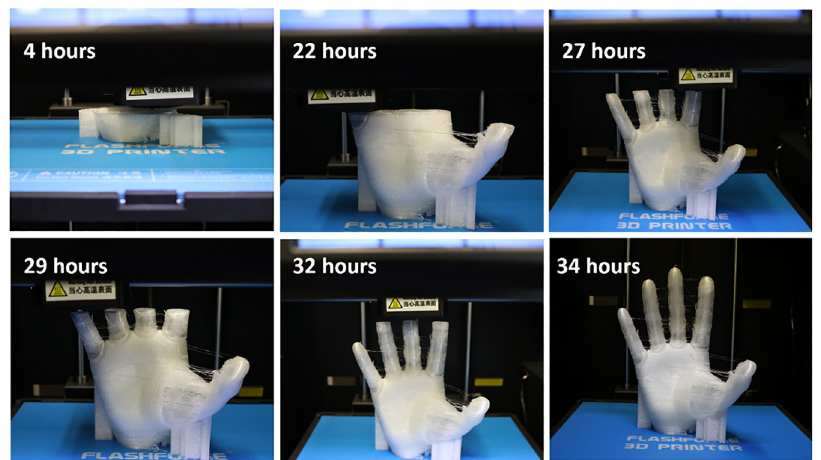
Fig 6. Time lapse of 3D printing of X-Limb.